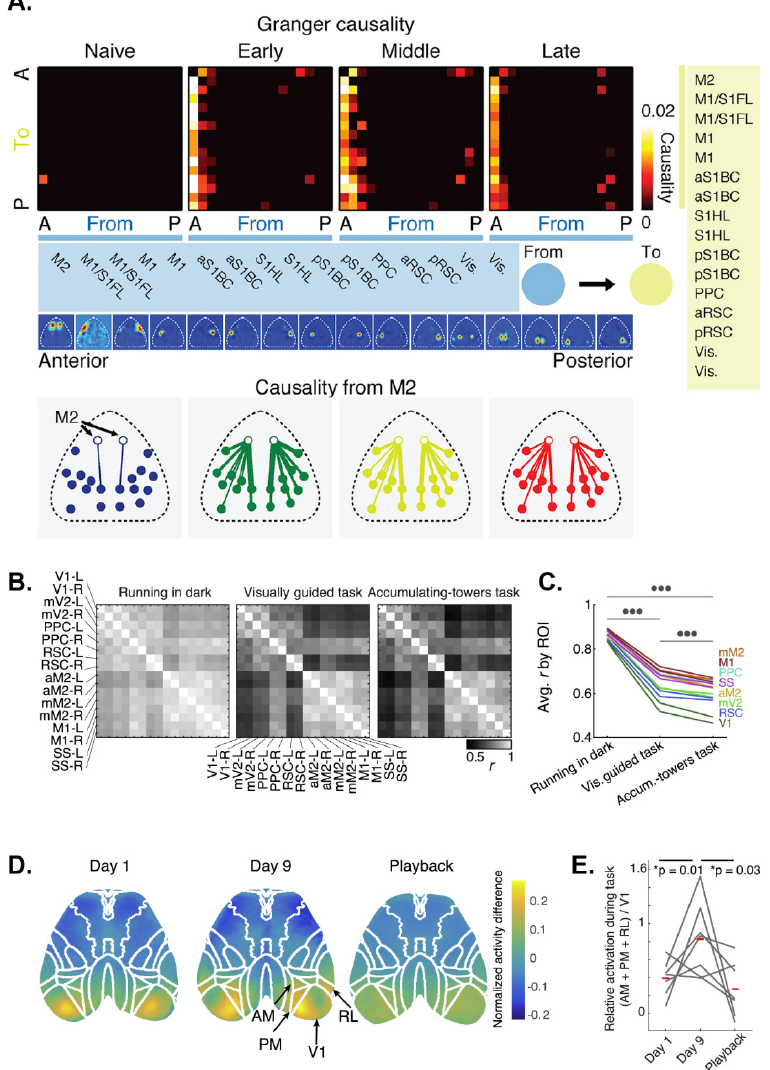
Figure 4. Multi-method investigation of cognitive processes using wide-field Ca 2+ imaging. ( A ) Ac- tivity flow between M2 and other brain regions increases during motor learning. Matrices of granger causality values from M2 (left most column) to other brain regions (left to right, anterior to posterior) during four stages of learning of a motor task, in which mice are trained to press a lever beyond a specific threshold. Bottom row: spatial causality maps showing directionality from M2 to various regions are increased with learning. Modified with permission from [18]. ( B ) Correlation matrices showing differences in brain functional connectivity during different behavioral tasks requiring dif- ferent levels of complexity. Panels ( B , C ) adapted with permission from [95]. ( C ) Line plot showing the average correlation coefficient per brain region between different behavioral paradigms (RM One-Way ANOVA p = 3.1 × 10 − 23 with post hoc Tukey’s multiple comparisons; p < 0.001; circles). ( D ) Cortical activation relative to baseline during a closed loop visual task. At Day 1 in task learning mice, cortical activation is limited to the primary visual cortex. In Day 9, task proficient mice, cortical activation extends to high visual areas. In task proficient mice, during passive task playback, there is no relative activation of the visual areas. ( E ) Activation of high visual areas relative to primary